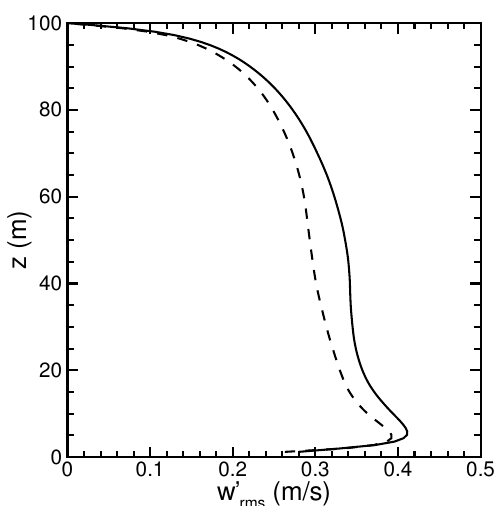
Figure 7. Vertical profiles of vertical velocity fluctuation rms w (cid:48) rms . The solid line is for the plane-progressive wave case, and the dashed line is for the flat-surface